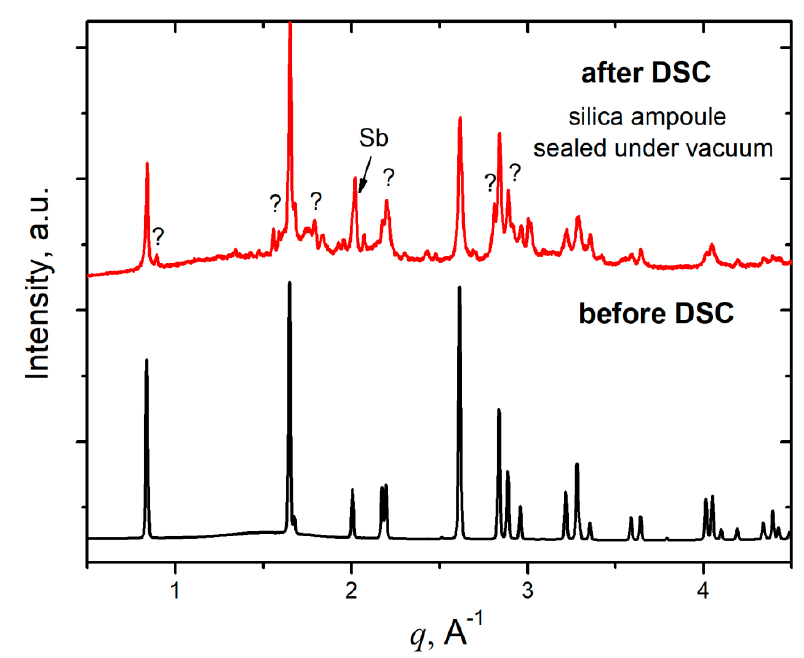
Figure 5. Comparison X-ray powder diffraction patterns of NaZnSb before (black) and after (red) DSC measurement. Data were collected using laboratory PXRD (after) and synchrotron PXRD (before). Before the DSC measurement, the pattern corresponds to the calculated pattern of NaZnSb phase; thus, no impurities are present. Traces of Sb were detected after DSC measurement in an evacuated and flame sealed silica capillary together with a plethora of new peaks emerging in the powder diffraction pattern, indicating the formation of unknown compound(s).